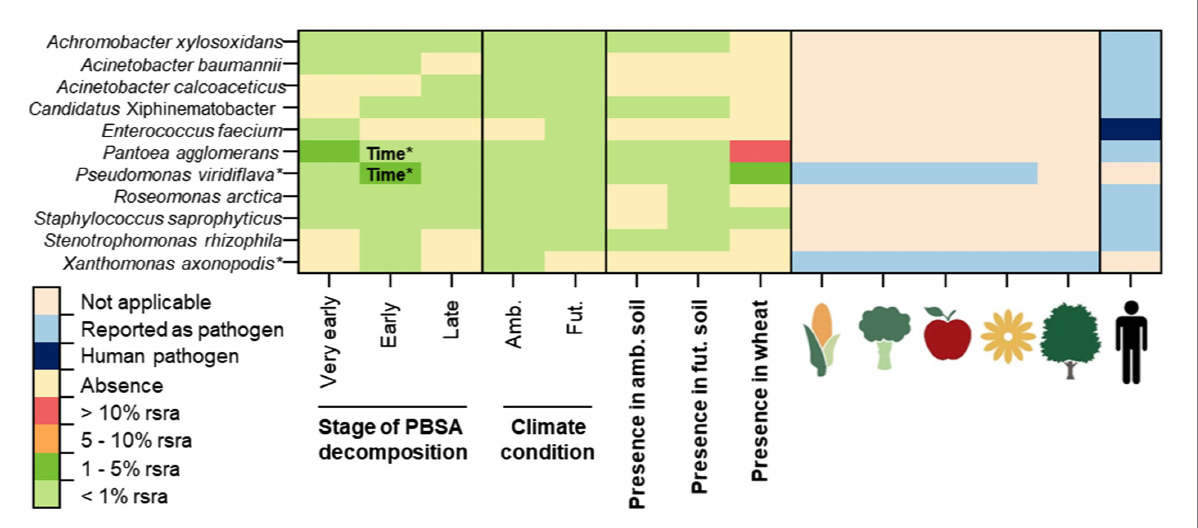
FIGURE 2 The occurrence of potentially pathogenic bacteria detected in decomposing PBSA films (at very early, early and late stages of decomposition) in soils of ambient (amb.) and putative future (fut.) climate conditions using next generation sequencing (NGS). Their presence in early decomposing wheat straw is also shown. Pathogens are separated as plant pathogens (including, pathogens of different plant functional groups: cereal crops, vegetables, fruits, ornamental plants and trees), opportunistic human pathogens and human pathogens identified according to relevant references (Supplementary Table S1). Symbols of each plant and human pathogen are introduced in Figure 1. Time* indicates significant effect accoding to repeated measure ANOVA ( p < 0.05; Supplementary Table S7). The abbreviation “rsra” refers to relative sequence read